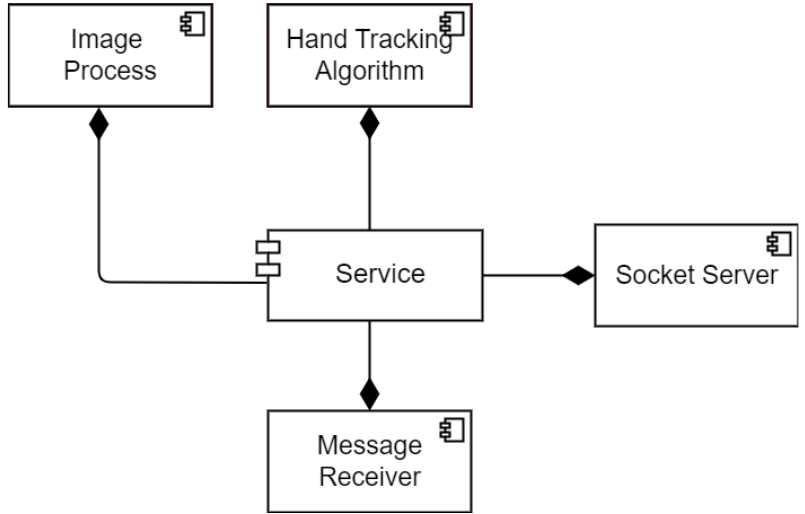
Figure 4. External hand-tracking module’s components.